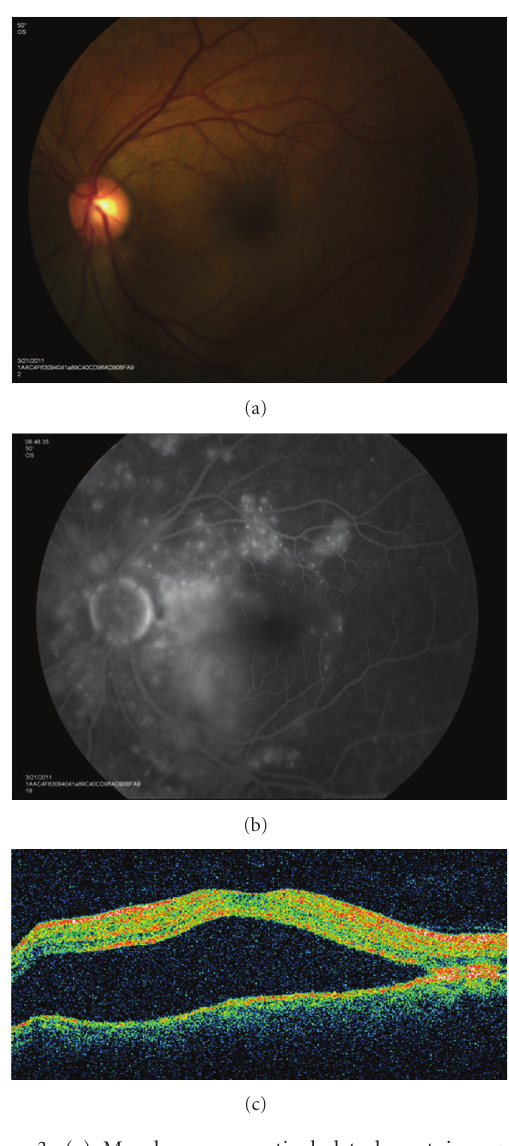
Figure 3: (a) Macular serous retinal detachment in a patient with lupus choroidopathy. (b) Multiple areas of hyperfluorescence seen on fluorescein angiography caused by increased vascular permeability of the choroidal circulation. (c) Large accumulation of subretinal fluid is seen on optical coherence